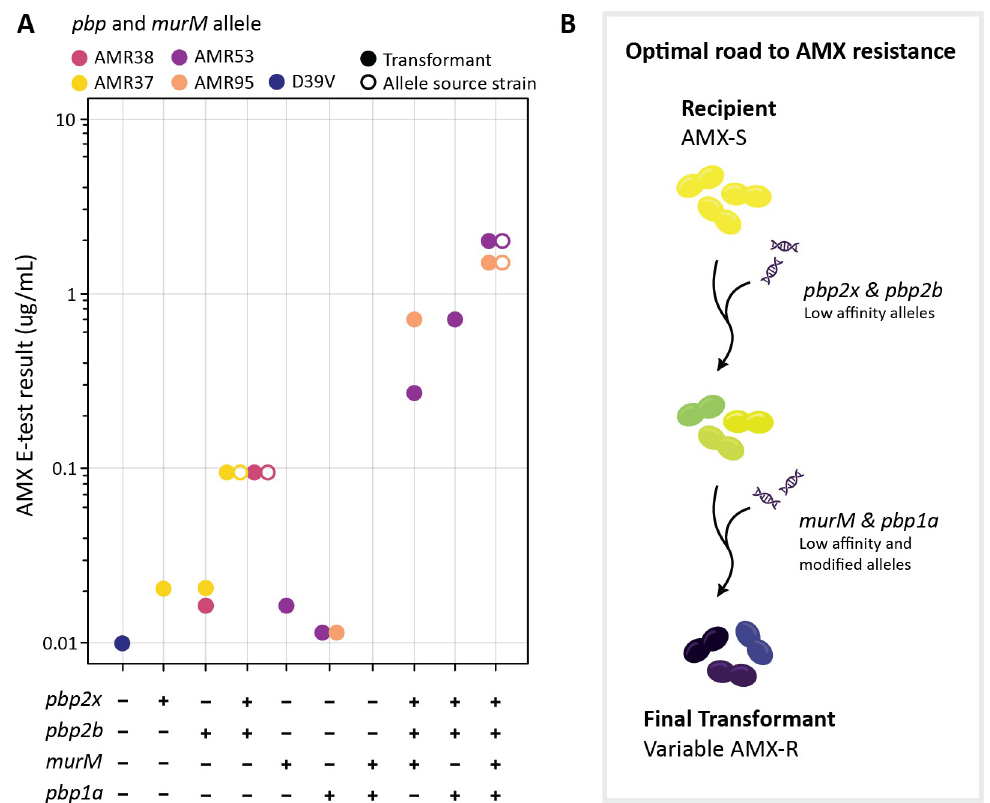
Fig 7. Uptake of mosaic pbp1a , pbp2b , pbp2x and murM is required and sufficient for clinically relevant amoxicillin resistance in S . pneumoniae . (A) AMX MICs determined by E-test for D39V transformant strains (solid circles) where pbp and murM alleles from different source strains (empty circles) were transformed in combination. Color shows allele source. (B) Schematic overview of the optimal road to AMX resistance development through horizontal gene transfer. Low affinity pbp2x was taken up in the first round of transformation in both datasets, whereas donor murM and pbp2b alleles were acquired in the first or second round, depending on recipient and lineage. Low affinity pbp1a was recombined in the second round, and only found in strains with AMX MICs above 0.75 μ g/mL. In principle uptake of low affinity and modified alleles could be achieved in a single (unlikely) or double